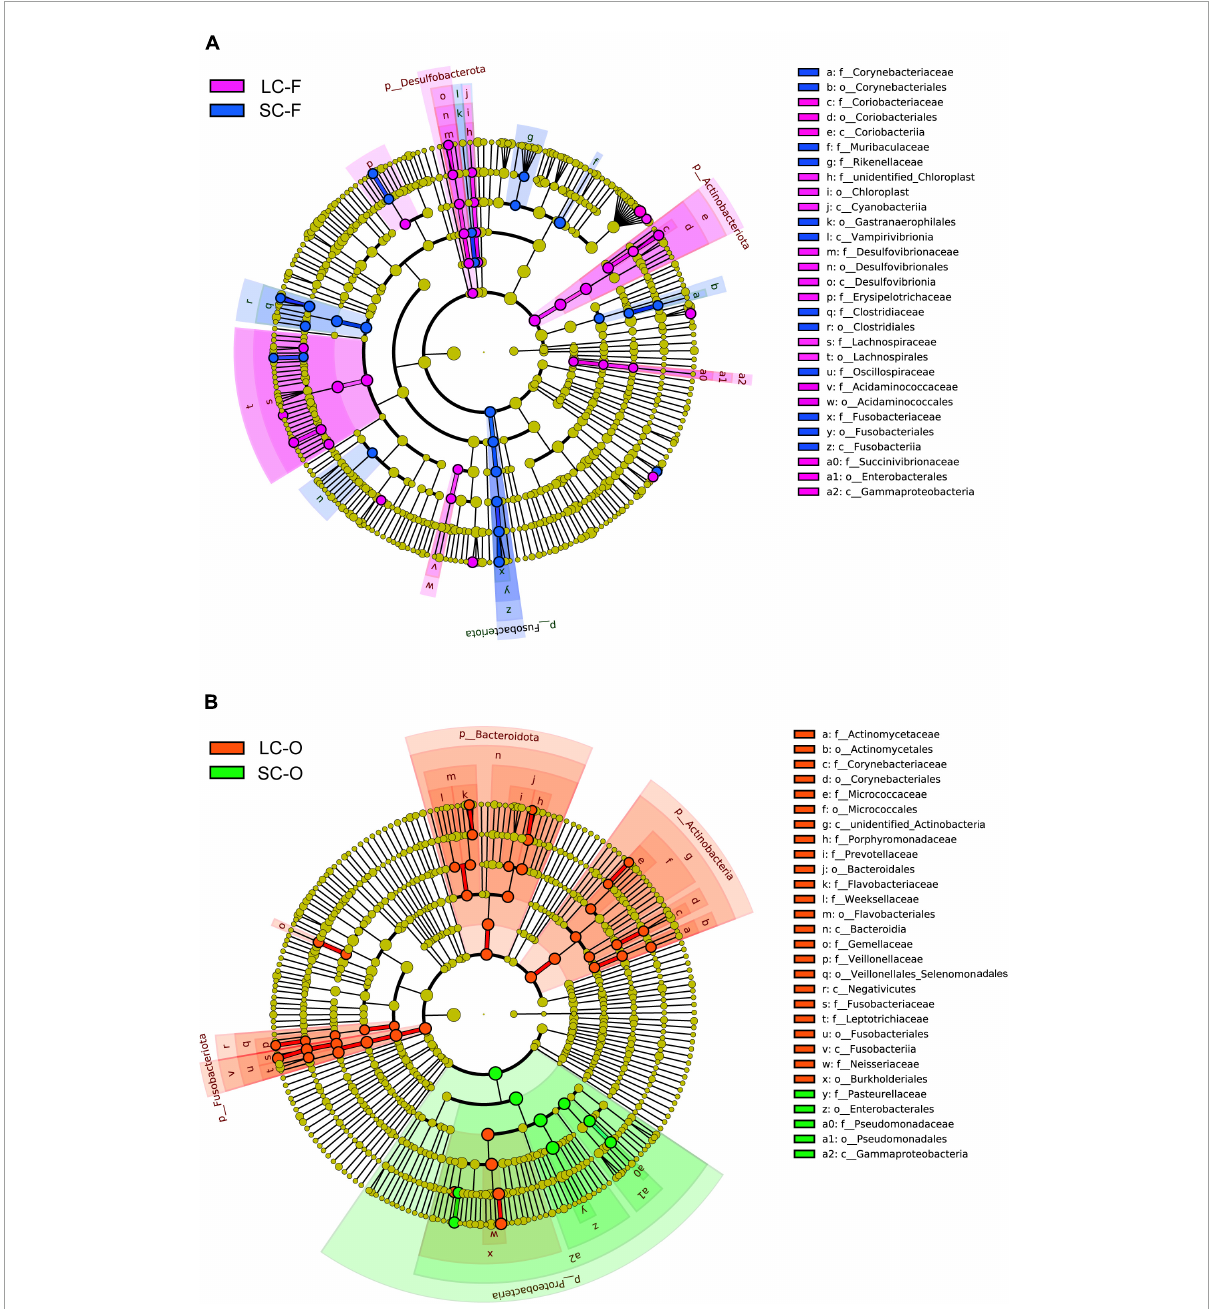
FIGURE5 Linear discriminant analysis (LDA) effect size (LefSe) analysis. The cladogram shows the significantly differential taxa (LDA Score > 3, P < 0.05) in fecal (A) and oral microbiome (B) between the groups under long-term (LC) and short-term captivity (SC). Taxonomic ranks at the level of genus (g), family (f), order (o), class (c), and phylum (p) were arranged from the inside to the outside.